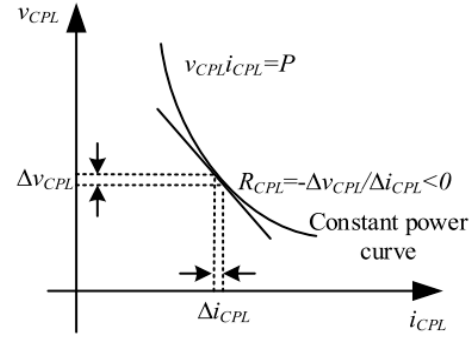
Figure 8. Voltage–current characteristics of CPLs.